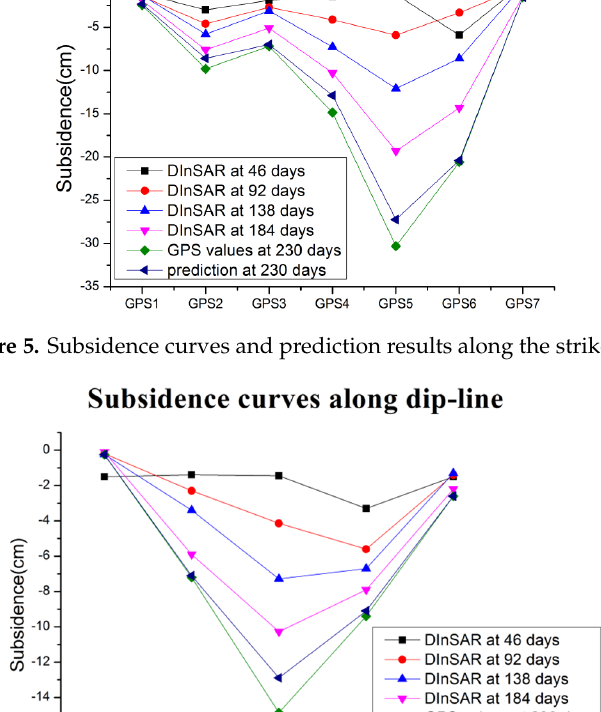
Figure 6. Subsidence curves and prediction results along the dip ‐ line.